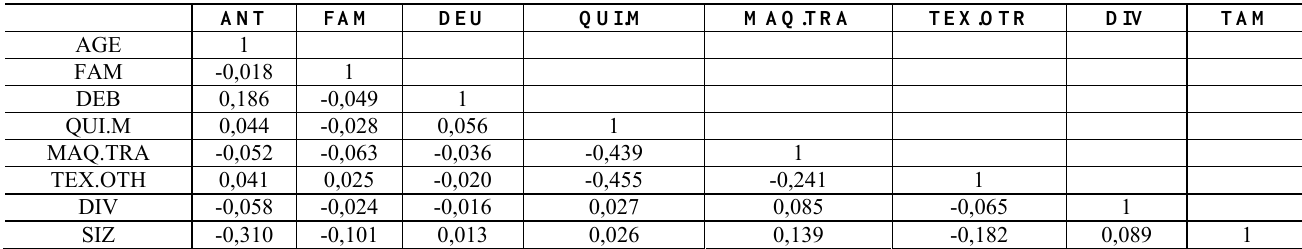
Table 7: Correlation coefficients between independent variables ANT FAM DEU QUI.M MAQ.TRA DIV TAM